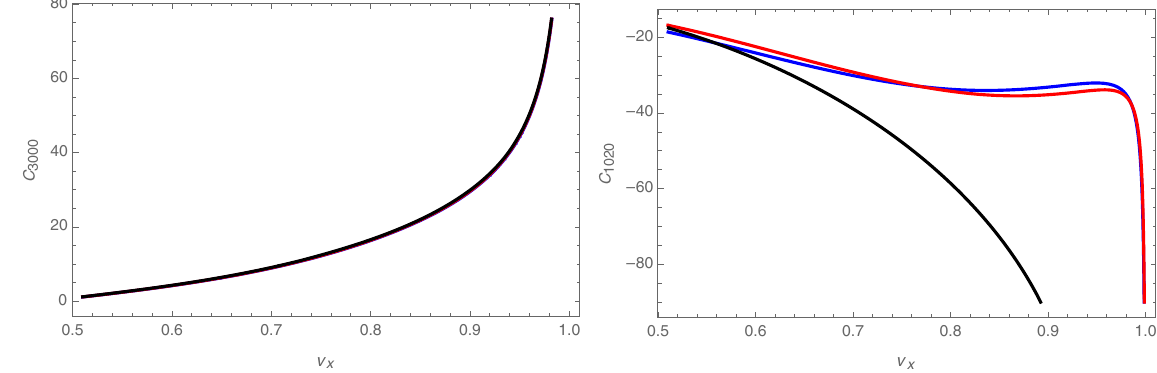
2 ν (left) and ν (right) as a function of the betatron tunes with various x x þ y